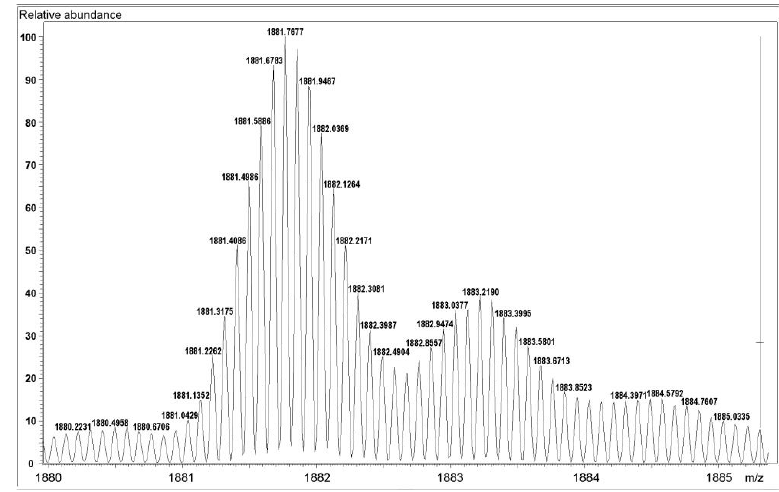
Figure 6. High resolution mass spectrum of compound IV-18-2. z = 11.